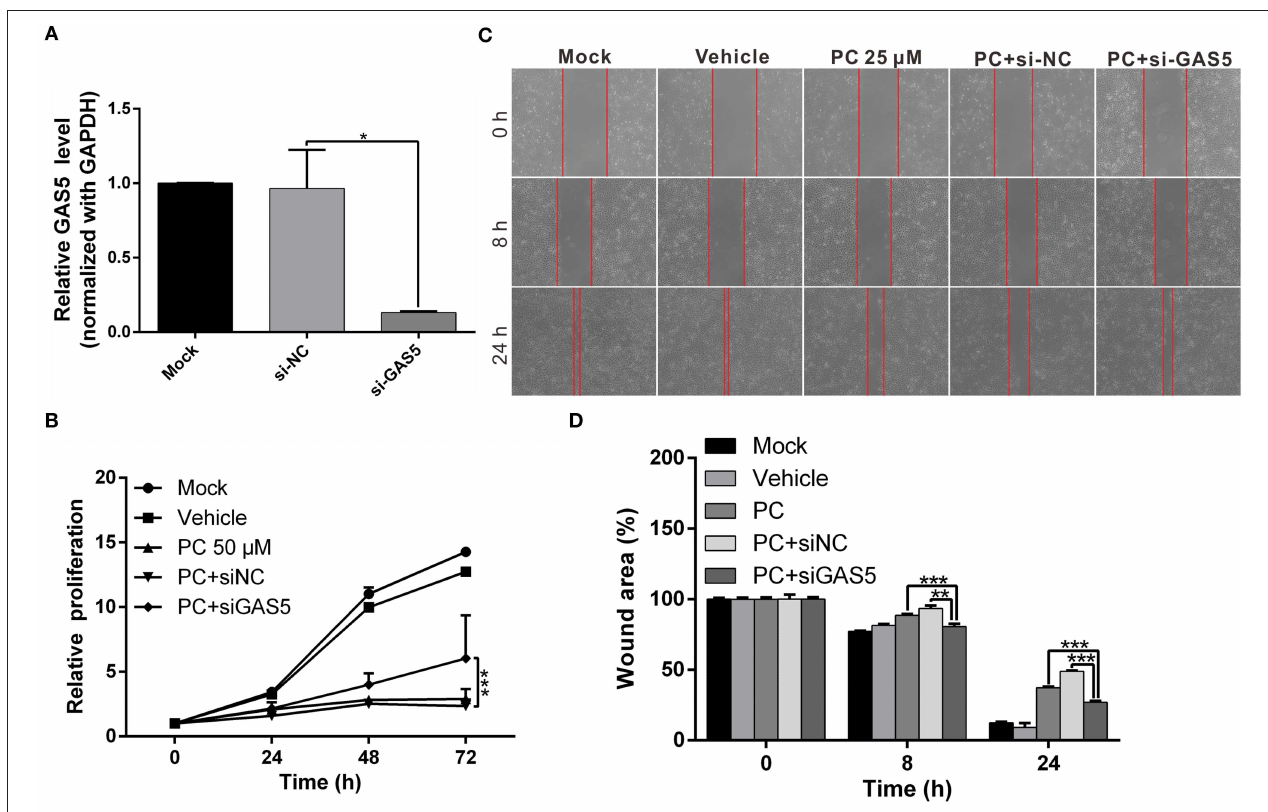
FIGURE 7 | The anticancer effect of psorachromene is exerted by inducing expression of lncRNA-GAS5. (A) Real-time PCR analysis shows the effect of siRNA treatments on the expression of GAS5 in OECM1 cells. GAPDH served as an internal control. (B,C) The inhibitory effects of psorachromene on cell proliferation and migration were significantly reversed by treatment with GAS5 siRNA (50nM) in the OECM1 cells. The quantitative cell migration result was shown in (D) . * p < 0.05, ** p < 0.01, *** p <